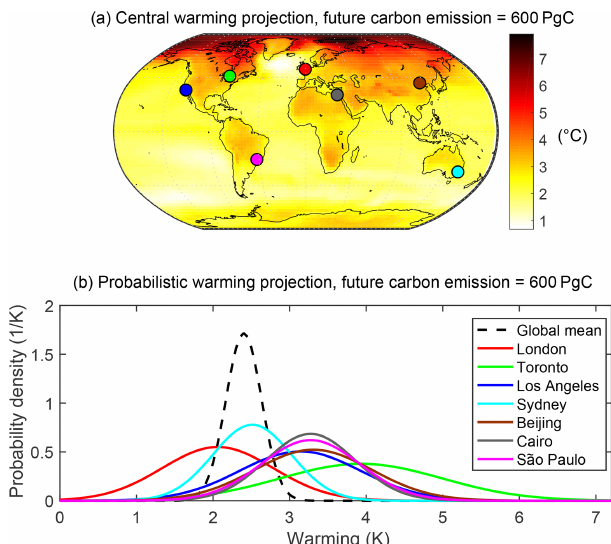
Figure 5. Warming projections when future emissions reach 500PgC from the start of 2018. (a) The spatial distribution of the central warming projection. (b) The probability distributions of lo- cal warming for seven locations (solid colour lines) and the global surface average (black dashed line). All warming projections given relative to the average temperature from 1850 to 1900. Global mean warming projected from the quadratic approximation to the history- matched WASP ensemble (Eqs. 3 to 6) using the generic ≥ 2 ◦ C spatial